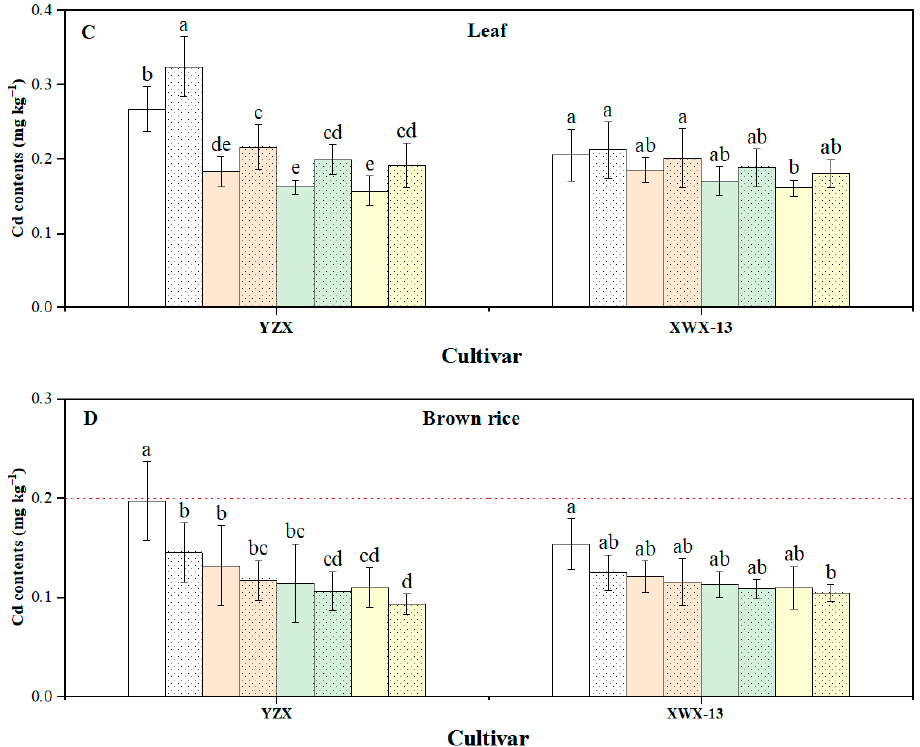
Figure 2. Effects of the soil amendments and foliar inhibitor on the Cd content of the late rice. ( A ) roots, ( B ) stems, ( C ) leaves, and ( D ) brown rice. The same letters indicate that no significant differences between the treatments for each cultivar were found using least significant difference tests ( p < 0.05). Different letters indicate that significant differences were found between the treatments for each cultivar using least significant difference tests ( p <